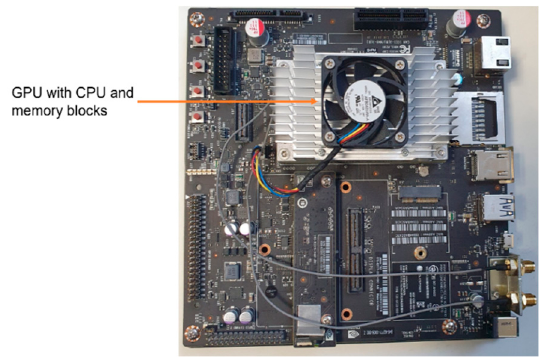
Figure 15. Jetson TX2 embedded system. Table 13. Comparisons of inference time and processing speed by proposed method and the state- of-the-art methods.